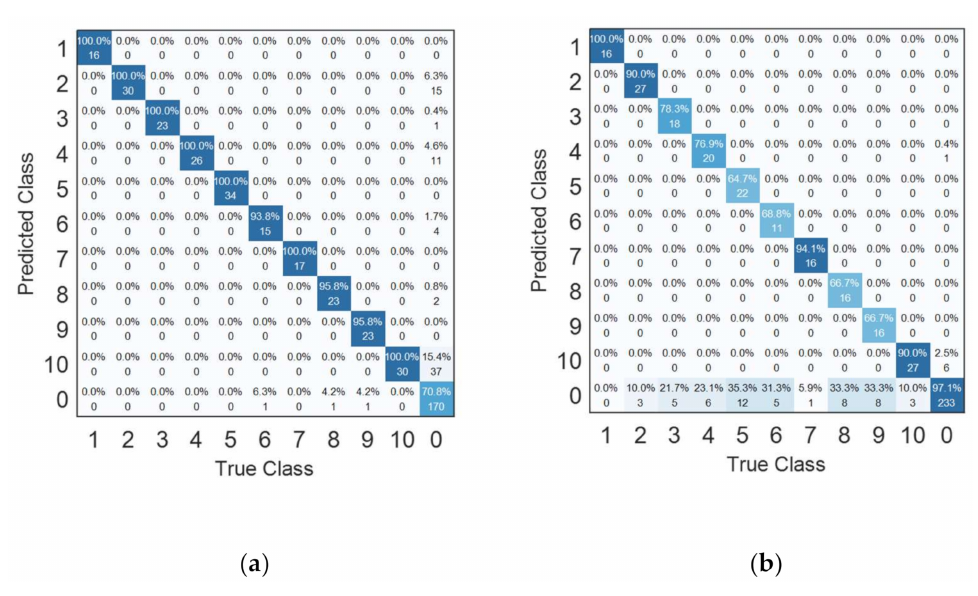
Figure 9. Confusion matrix of the proposed method computed based on mean rule combiners. ( a ) Softmax-threshold as basic classifiers; ( b ) OpenMax as basic